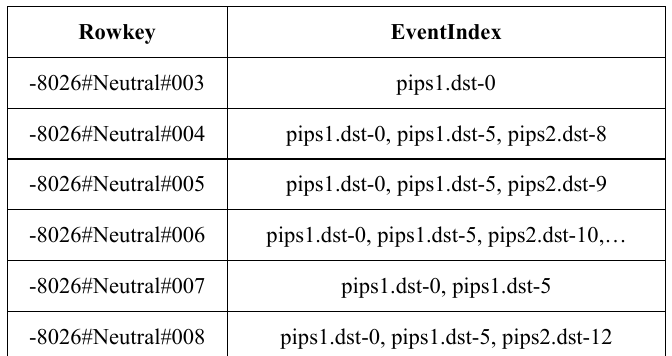
Table 1. Event Index examples in HBase.